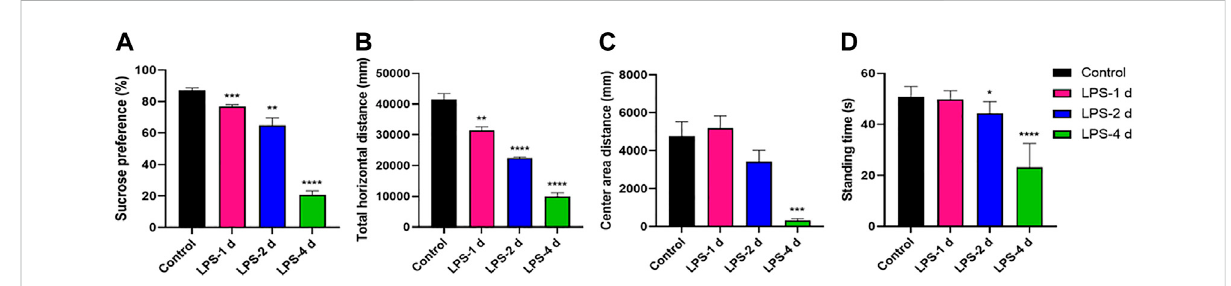
FIGURE 2 Behavioral tests results. (A) Sucrose preference in the sucrose preference test (SPT). (B) Total horizontal distance (mm) in the open fi eld test (OFT). (C) Center area distance (mm) in OFT. (D) Standing time (s) in the rotarod test. Data are expressed as the mean ± SEM (n = 10).* p < 0.05, ** p < 0.01, *** p < 0.005, **** p < 0.001, compared to the control group.